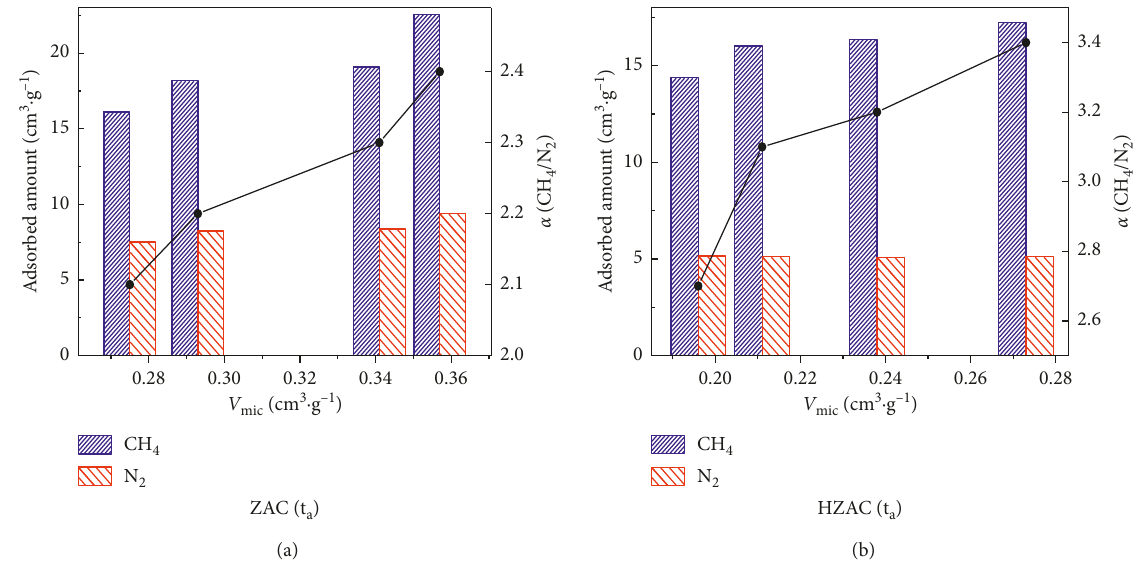
Figure 6: CH 4 and N 2 adsorption capacity and selectivity plotted of V mic : (a) ZAC( t a ) and (b) HZAC( t a ).